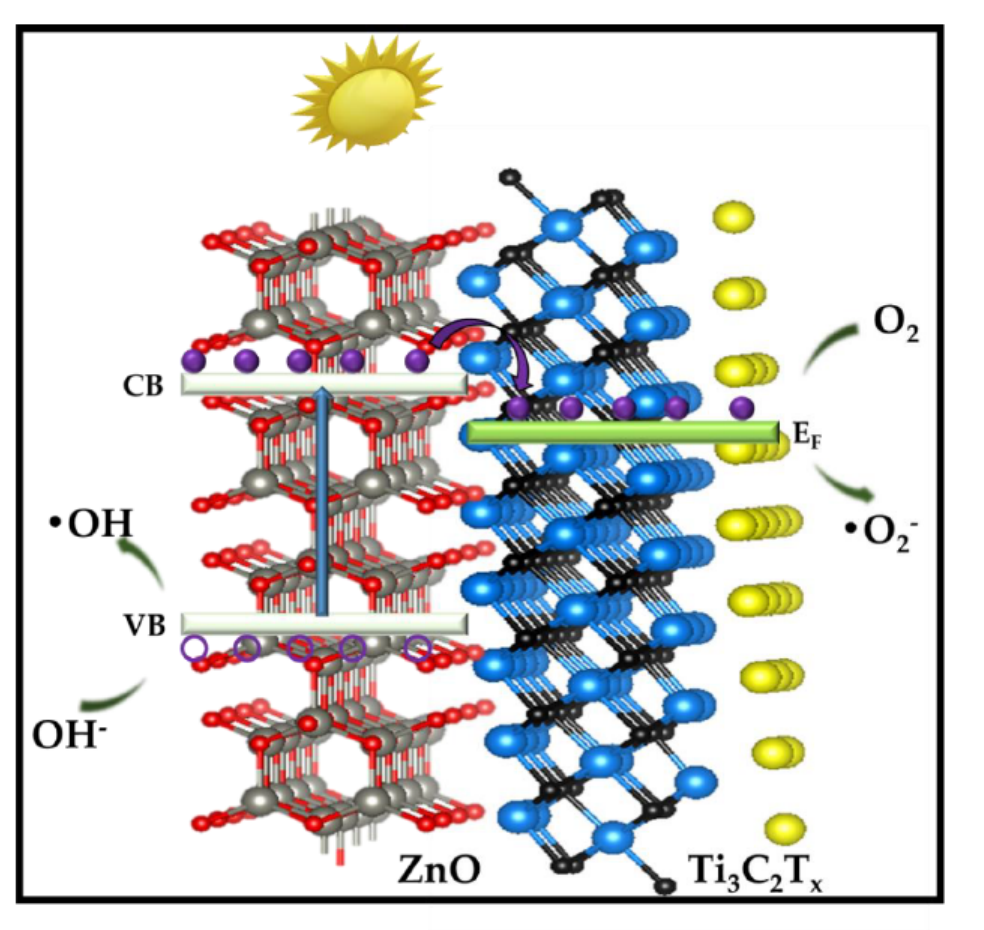
Figure 8. Proposed mechanism for the improved photocatalytic performance of the ZnO / Ti 3 C 2 T x hybrid